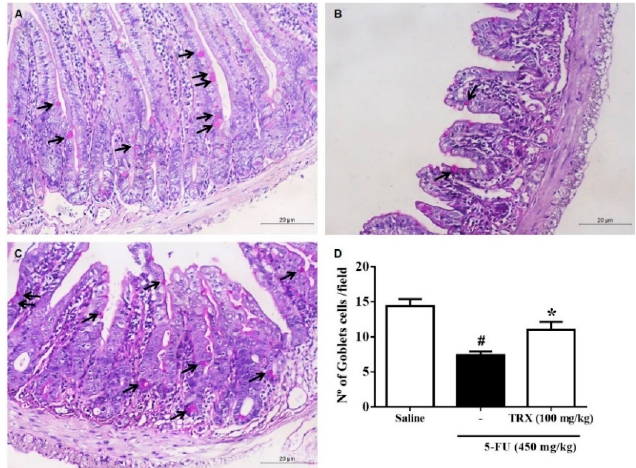
Figure 6. Goblet cell counts in the duodenal segment based on the Schiff periodic acid (PAS) staining. Panels ( A ), ( B ), and ( C ) correspond to Saline, 5-FU, and TRX-100 groups, respectively. ( D ): Statistical representation of experimental groups. Values are presented as mean ± SEM of the number of goblet cells per field. For the statistical analysis, one-way ANOVA followed by Tukey’s test was used. #: p < 0.05 in 5-FU vs. Saline group; *: p < 0.05 in TRX-100 vs. 5-FU group.